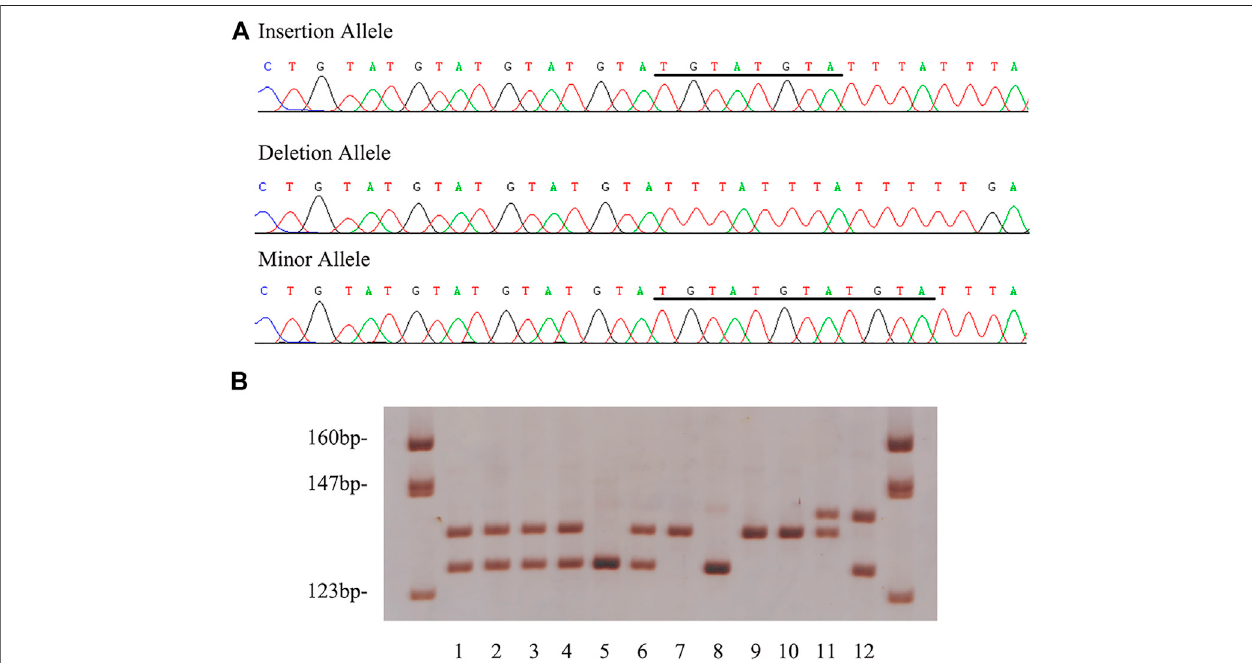
FIGURE3| Exampleoutputfromsequencing andgenotypingassaysofrs150703258. (A) Thegenotypingoutcomesbyusing7%non-denaturingpolyacrylamide gel electrophoresis (PAGE) and silverstaining(lane 7,9and 10, ins/insgenotype; lane1, 2,3, 4and 6,ins/del genotype; lane5and 8,del/del genotype; lane11,rare/ins genotype; lane 12, rare/del genotype). (B) The sequencing results of insertion, deletion and rare allele in template strands. The underlined bases indicate the “ GTATGT AT ” / “ GTATGTATGTAT ” insertion in coding strands.